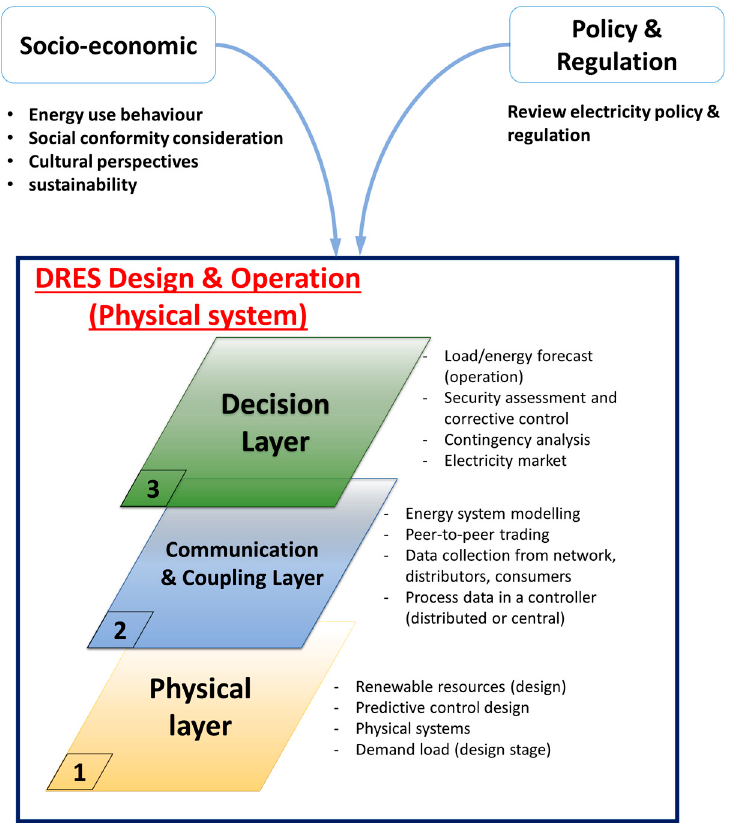
Figure 2. Implementation layers of DRES within energy sector and main science and technical gaps.